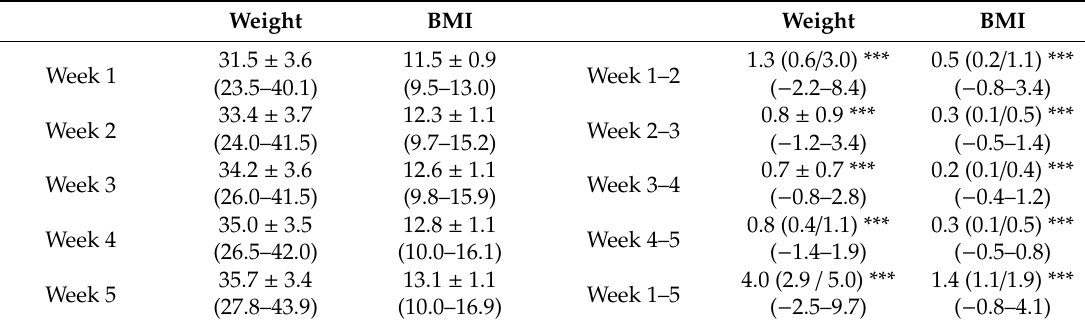
Table 1. Weekly change in weight and body mass